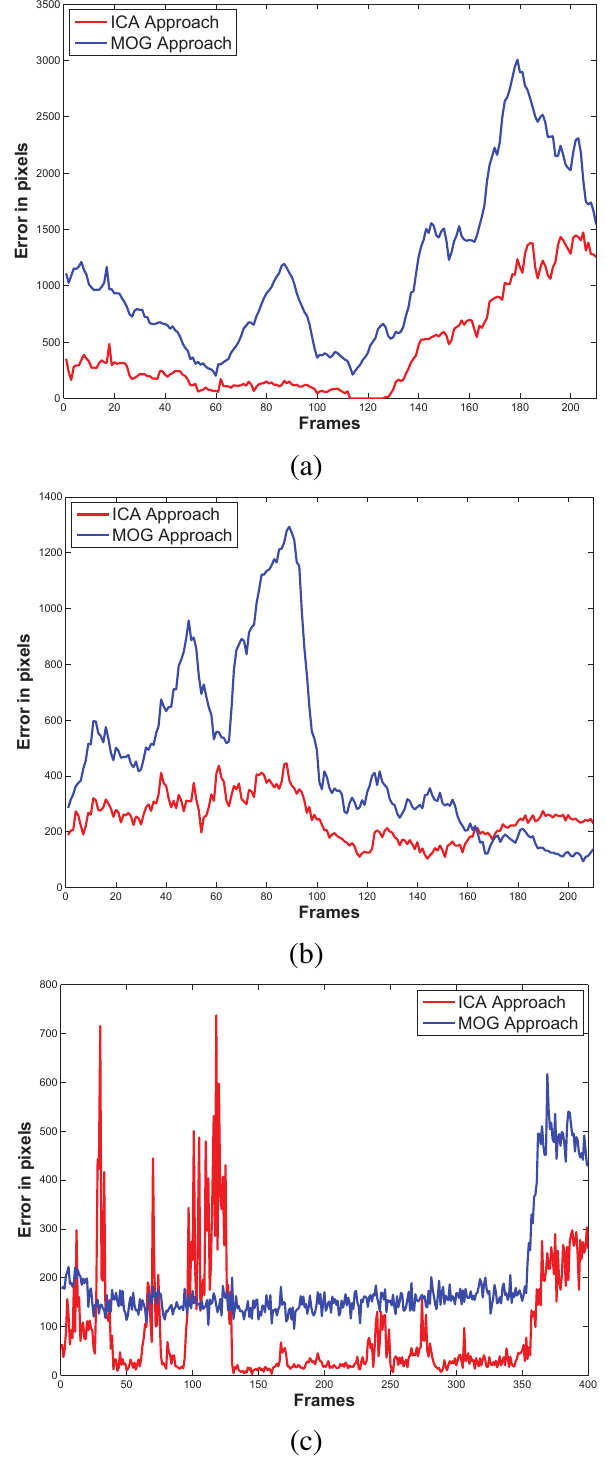
Figure 5. False-positive errors resulted after comparing ground truth against our approach and the MOG approach. In (a), the first train station scenario, where the MOG approach is more sensitive to introduce noise; on the other hand, the proposal adds less error of motion. In (b) the second scenario of the train station at a different perspective, the behavior is similar, except for the end, our proposal has a significative major error bias. In outdoor scenarios (c), the MOG is more sensitive to luminance variations than our